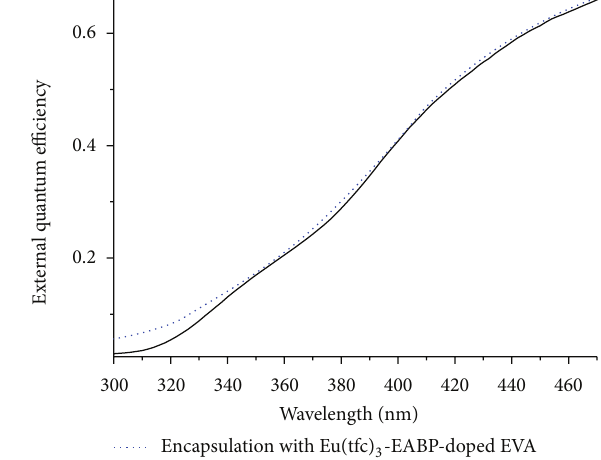
Figure 2: EQE measurements recorded on c-Si-based test modules encapsulated with undoped (solid line) and Eu(tfc) 3 / 4,4 󸀠 bis(diethylamino) benzophenone-(Eu(tfc) 3 -EABP-) doped EVA (dots). The only down-shifting spectral region has been showed for better